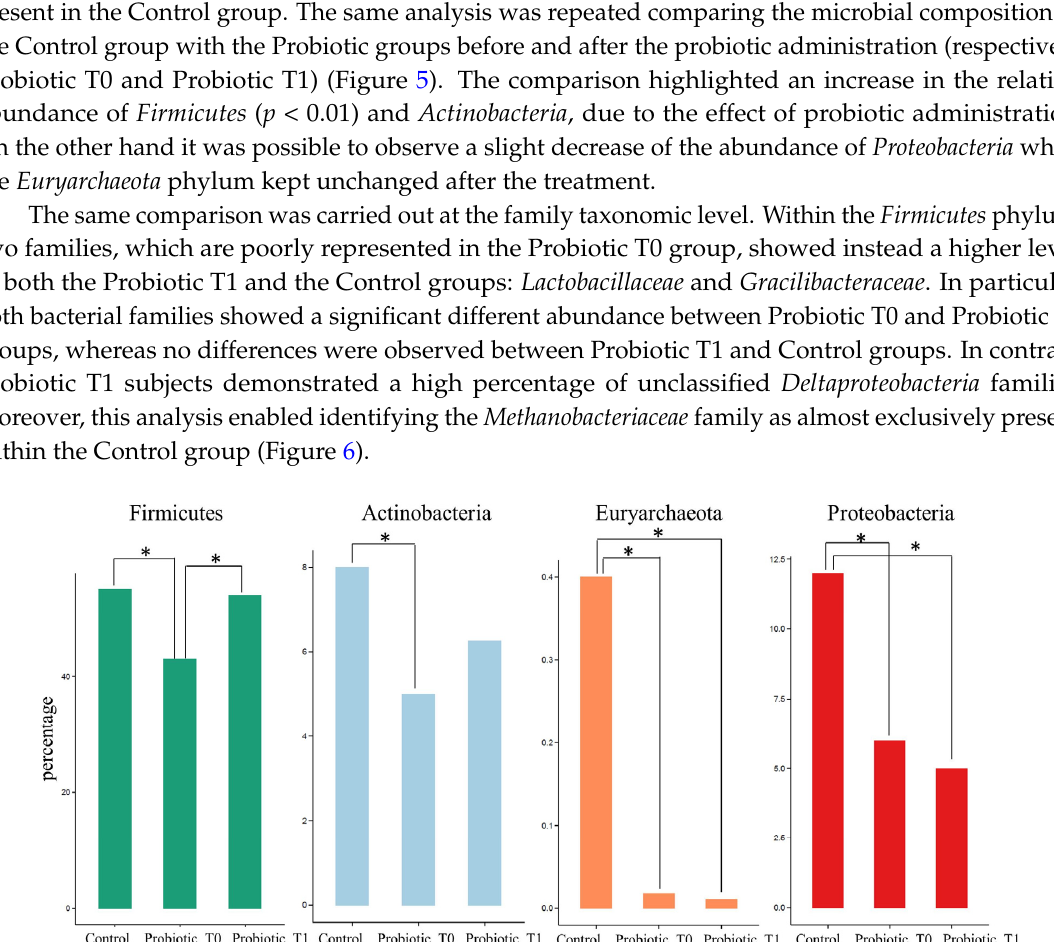
Figure 5. Significant differences in phyla relative abundance among Control, Probiotic T0 and Probiotic T1 groups. The * indicates p < 0.01. Supporting information on relative abundance and p -values is found in Tables S4 and S5.